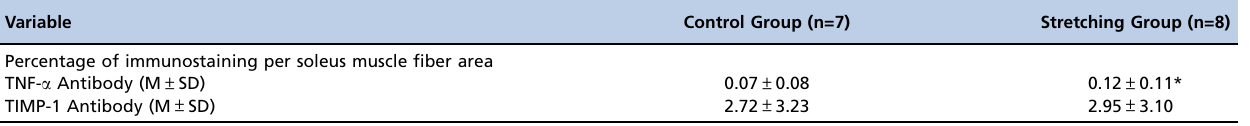
Table 1 - The acute effects of stretching on the immunostaining of the soleus cross-sections.